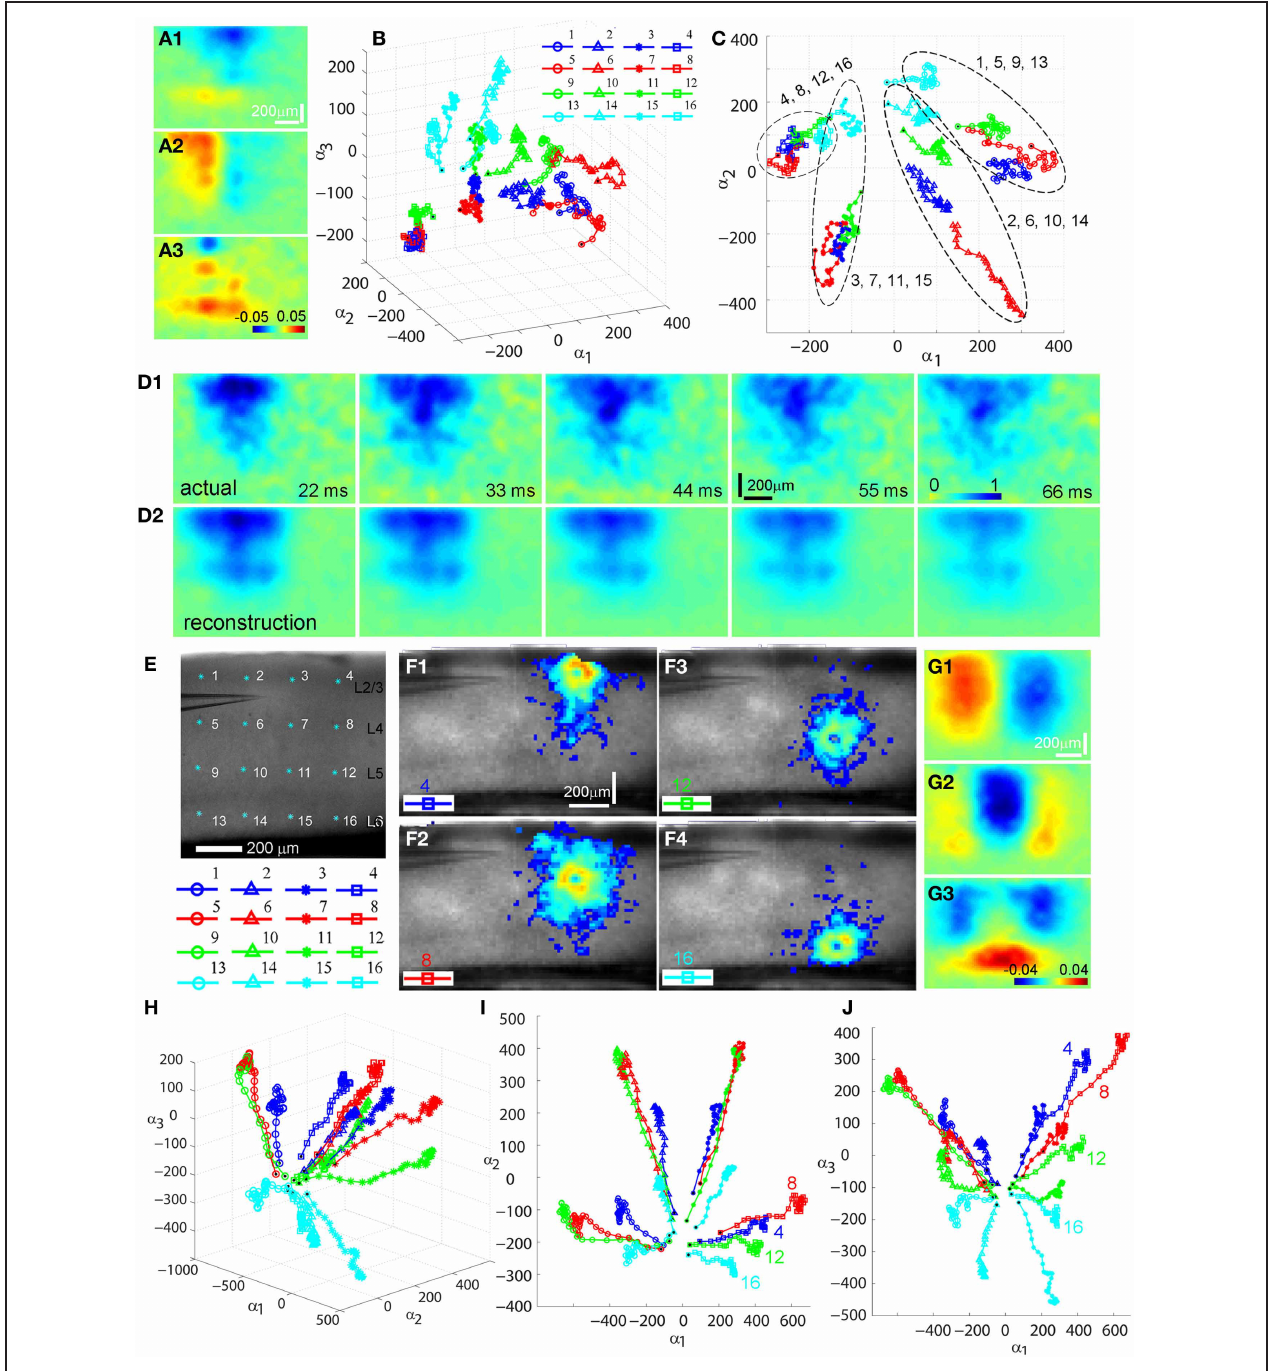
FIGURE 3 | Principal component analysis (PCA) of photostimulation- evoked VSD responses. (A–D) and (E–J) present PCA of two different VSD image data sets. (A–D) are from PCA of the data set as shown in Figure 1 . (A1–A3) Shows the first three principal spatial modes (shown as images) derived from the PCA decomposition of the combined VSD image sequence from the 16 stimulation sites ( Figures 1 B1–B16 ) (See the section “Materials and Methods”). The first 30 time frames (66ms) of the image sequence after photostimulation were used for analysis. (B) Shows the time varying expansion coefficients (trajectories) of each of the three principal modes in a 3D phase space. Each curve corresponds to one of the 16 responses from